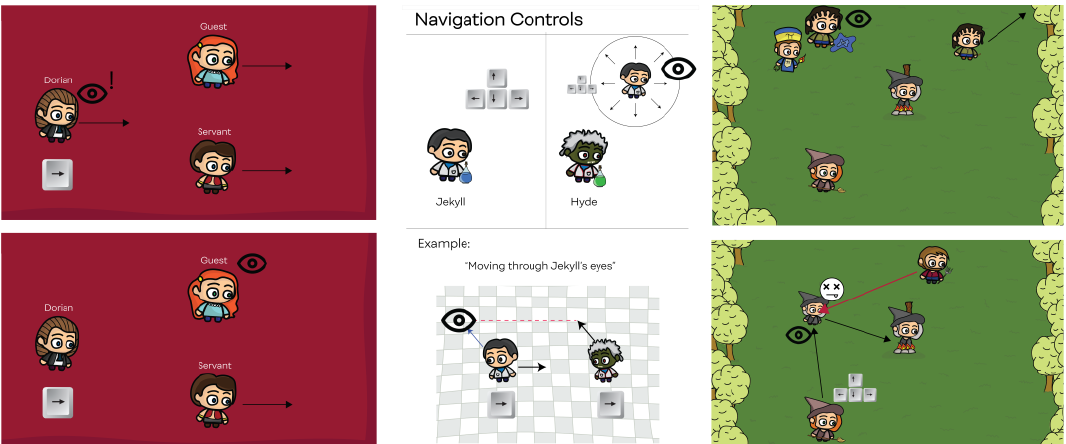
Figure 3. Twileyed ’s three games’ rules. ( Left ) “Dorian’s Pictures” based on Selection and Social Gaze. ( Center ) “Jekyll and Hyde” based on Navigation and Gaze Power. ( Right ) “The Witches” based on Aiming and Gaze